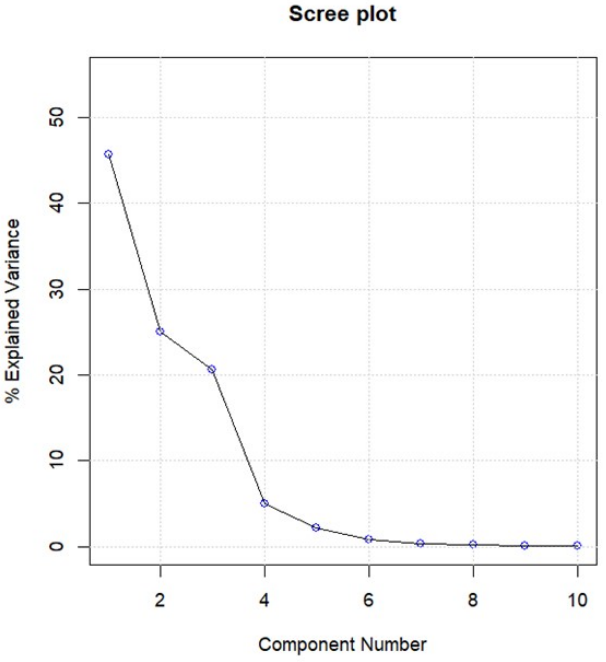
Figure 3. Scree plot of A 36,521 data matrix.